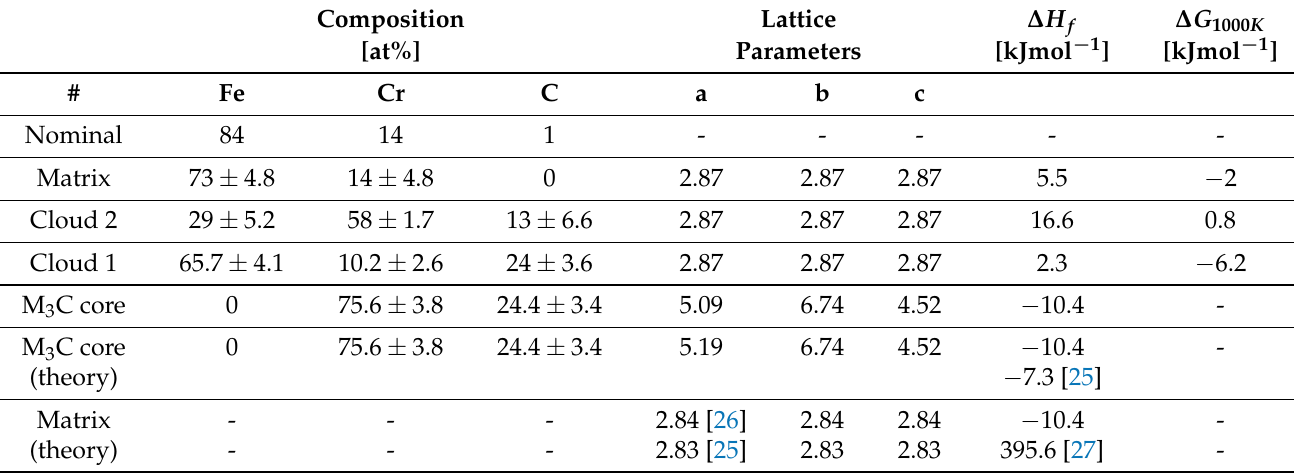
Table 1. Experimental lattice parameters a, b, and c (current work ((transmission electron microscopy (TEM) data; syn- chrotron data)) in Å and enthalpies of formation ∆ H f in kJ · mol − 1 of bcc Fe 73 Cr 27 C 0 (Matrix), bcc Fe 31 Cr 58 C 11 (Cloud 2), and bcc Fe 10 Cr 65 C 25 (Cloud 1) steels and DO 11 Cr 3 C core. The obtained results for Fe 73 Cr 27 C 0 and Cr 3 C are compared to theoretical literature data from